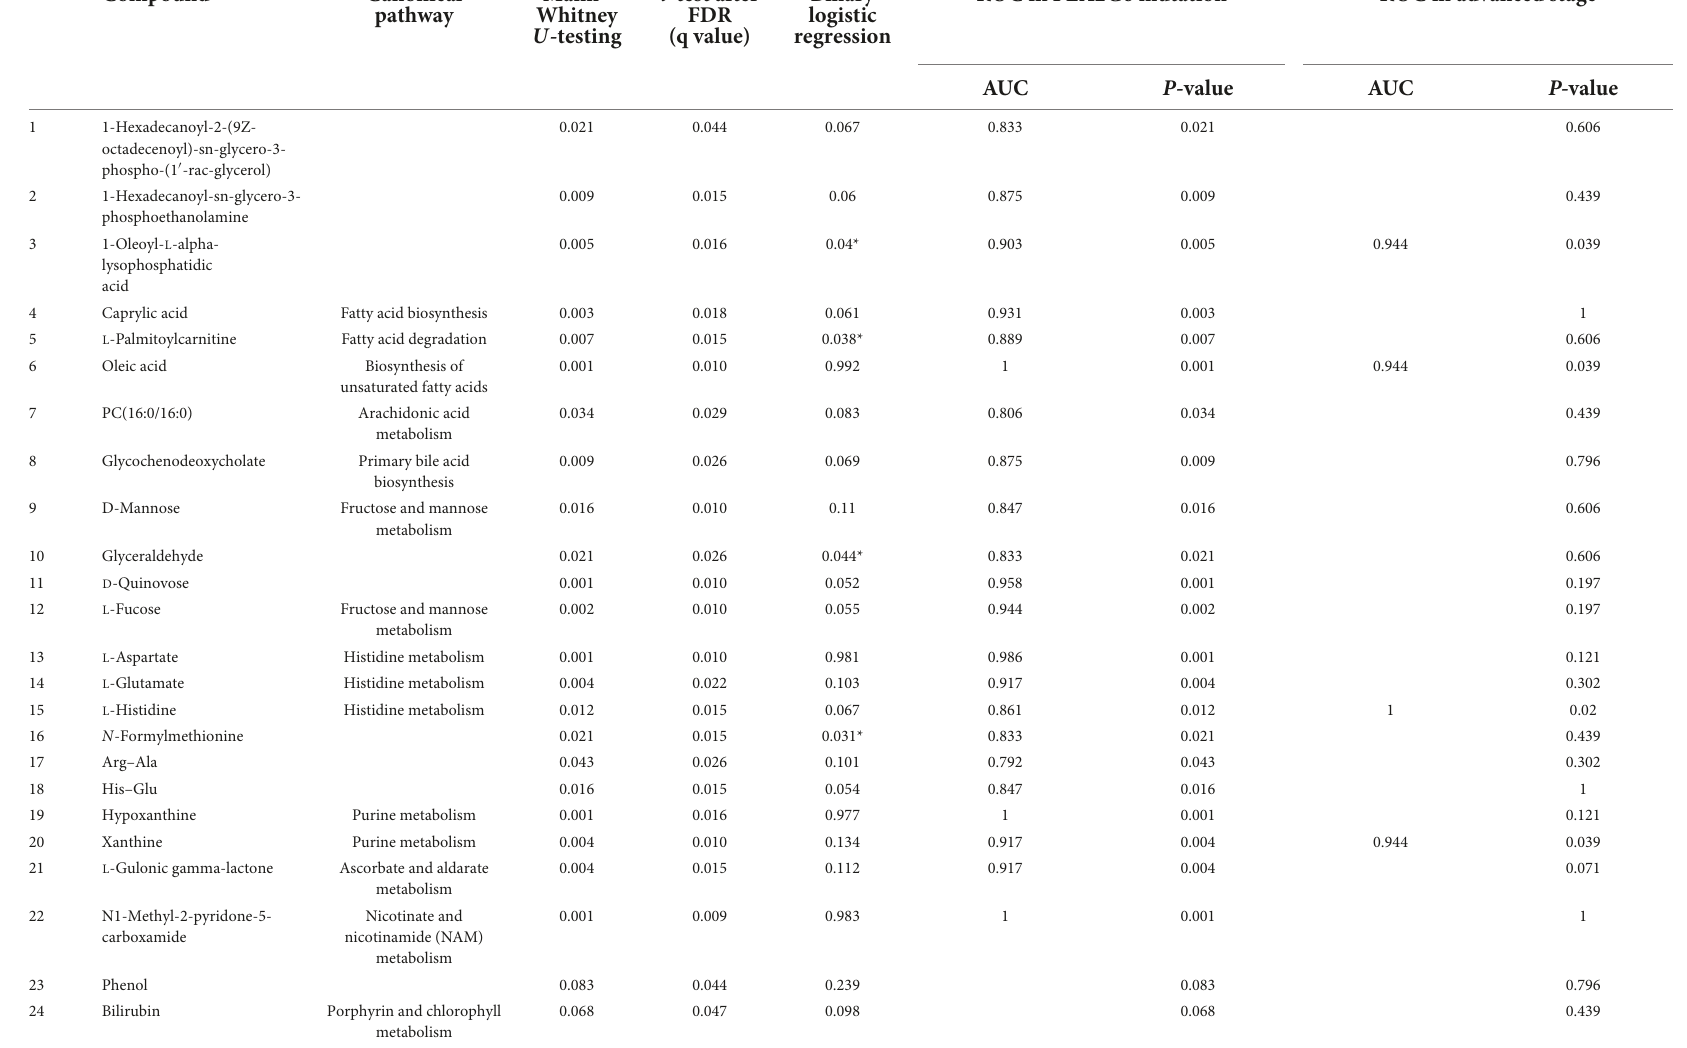
Shown are the results of statistical analysis in normalized metabolite levels in PARK14 cases and matched controls, case-control comparison by the Mann–Whitney U -test, t -test after FDR (false discovery rate) correction, binary logistic regression (with ageatexamandgenderascovariates),andreceiveroperatorareaunderthecurve(ROCAUC)assessmentsofpredictiveabilityindiagnosingPLA2G6mutationsandadvancedstages(H&Y ≥